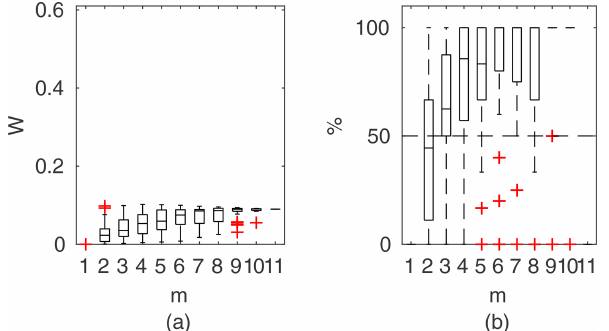
Figure B21. PTLM results for the Ritobacken case study, spring 2012: (a) averaged relative confidence widths W as a function of observation set size m used for model identification; (b) percentage of verification points enclosed by the confidence intervals (100% denotes all points within intervals, box spans over the 25% and 75% quantiles, the median is given with horizontal line, whiskers indicate the result extent, and cross marks are for extreme